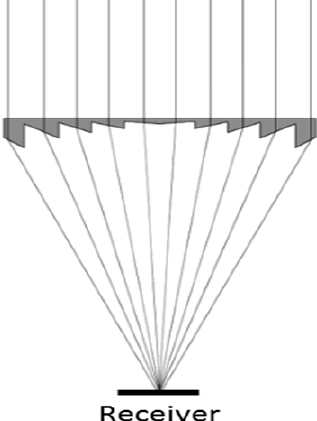
Figure 7. The irradiance distribution in the conventional design of the Fresnel lens, in which there is only one focal point at the center of the receiver.